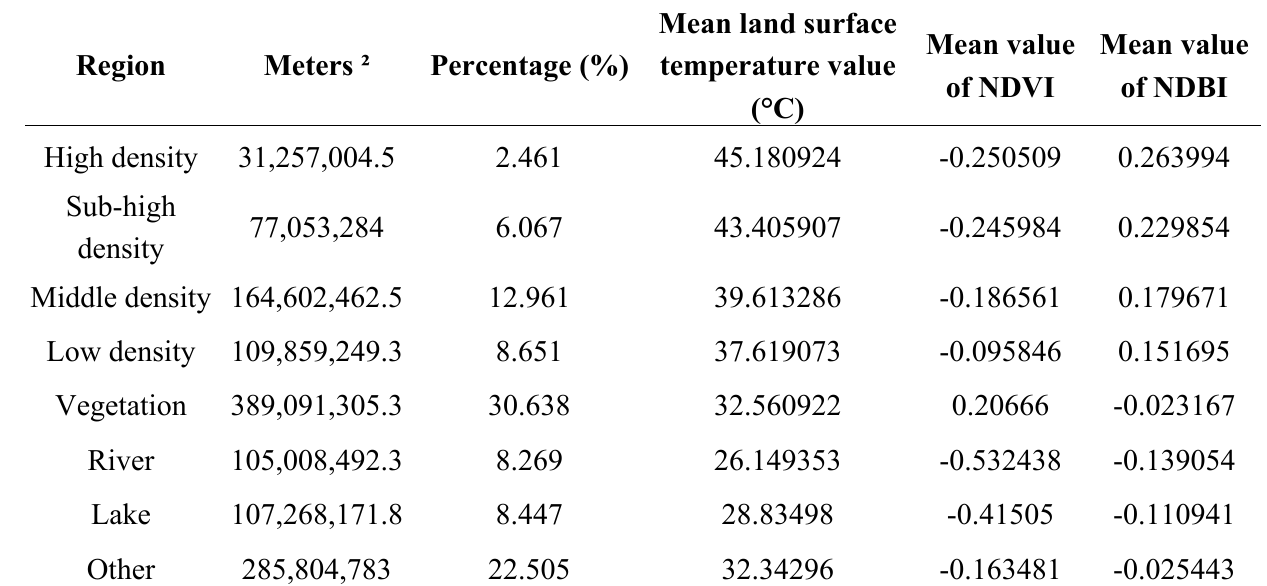
Table 1. Index of underlying surface of the big scale region of Wuhan.